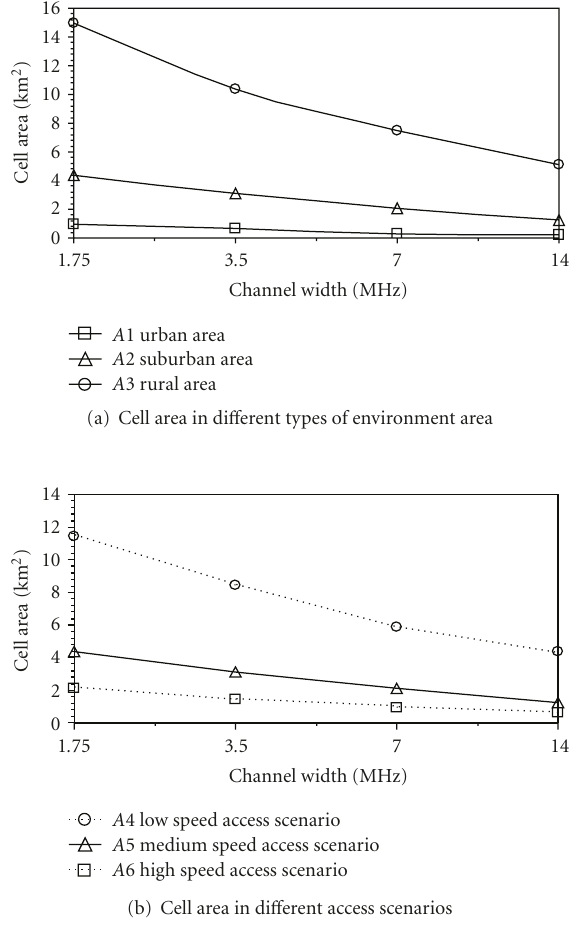
Figure 5: Relation of coverage area of single cell to access rate and type of environment areas. Table 7: Assumption of modulation distribution in